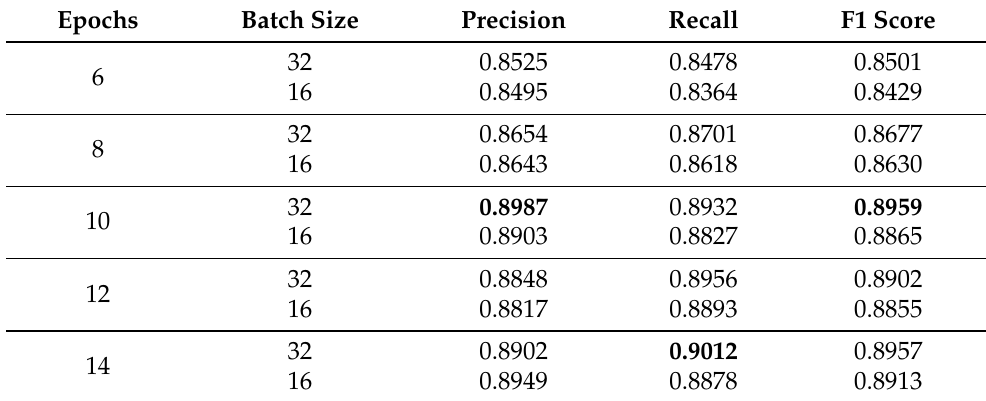
Table 2. Performance of SentiBERT-BiLSTM-CNN under different hyper-parameter